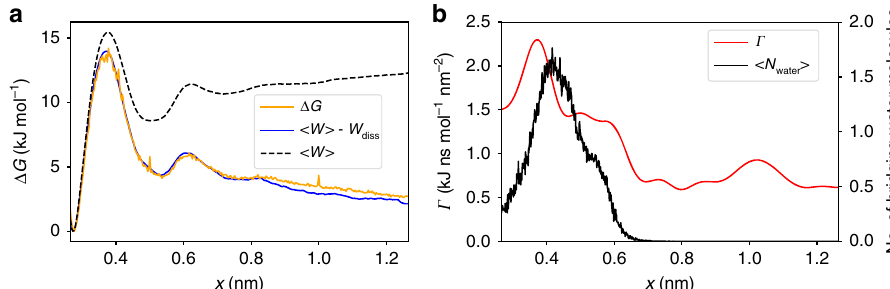
Fig. 1 Dissociation of NaCl in water. a Free energy pro fi les Δ G ( x ) along the interionic distance x , obtained from a 1 μ s long unbiased MD trajectory at 293 K (orange line) and 1000 × 1 ns TMD runs (blue line). Error bars are given in Supplementary Fig. 2. Also shown is the average work 〈 W ( x ) 〉 calculated from the TMD simulations (dashed black line). b Friction pro fi le Γ ( x ) (red) obtained from dcTMD after Gaussian smoothing together with the average number of water molecules (black), that connect the Na + and Cl − ions in a common hydration shell 34